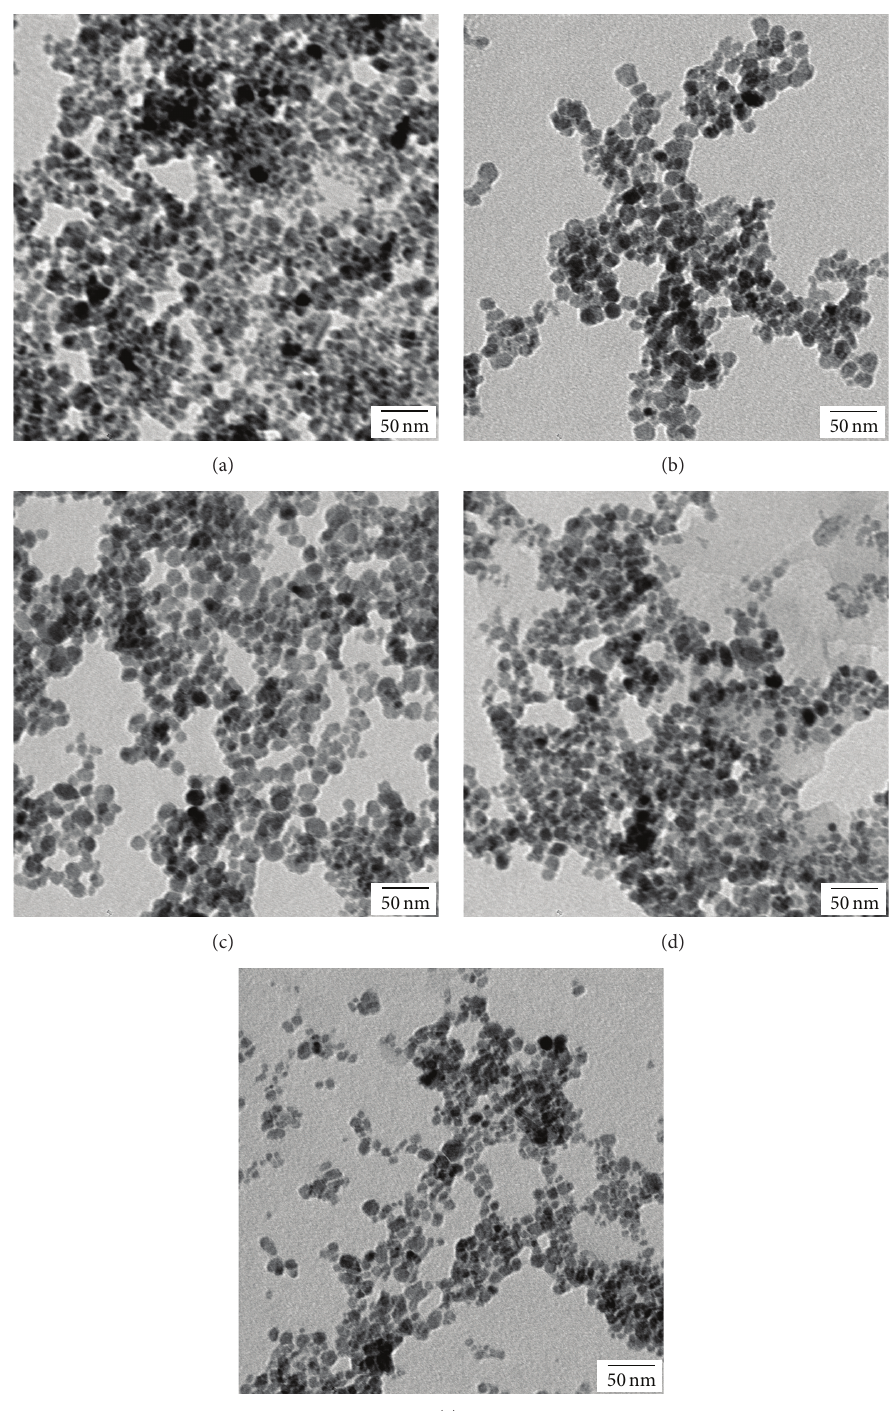
Figure 2: TEM images of maghemite nanoparticles for samples: (a) MNA2, (b) MNA4, (c) MNA6, (d) MNA8, and (e) MNA10.